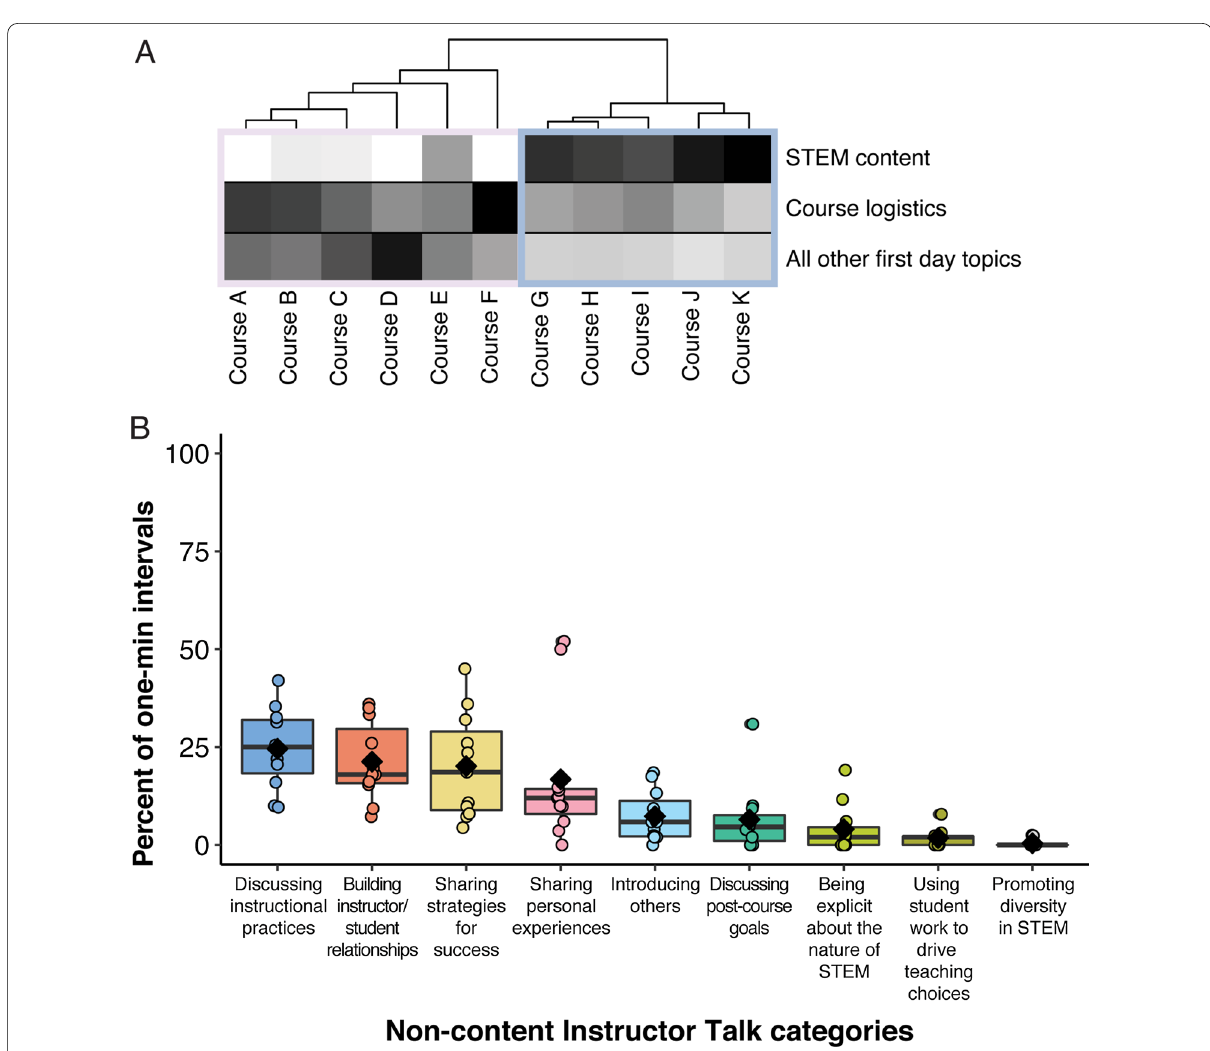
Fig. 1 Structure and non-content talk on the first day of class. A Heatmap of the amount of time instructors dedicated to course logistics, STEM content, or all other first day topics. Instructors are ordered based on dendrogram clusters, with the lower STEM content coverage cluster outlined in light purple and the higher STEM content coverage cluster outlined in light blue. B Boxplot of the percent of time instructors spend on each non-content Instructor Talk category. Each box represents the interquartile range (IQR). Whiskers represent 1.5 times the IQR. Lines within each box represent the median, and diamonds represent the mean for that category. Circles represent the data points from the 11 instructors and are included to show the spread of time within each